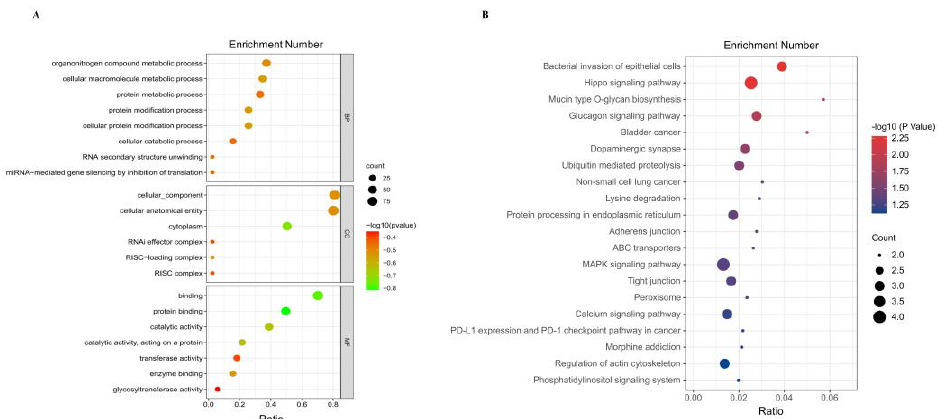
Figure 3. GO and KEGG enrichment analysis of DEcircRNA source genes. ( A ) GO analysis of DEcircRNA host genes in QE vs HE. The results are summarized in three main categories, biological processes (BP), cellular components (CC) and molecular functions (MF). ( B ) KEGG analysis of DEcircRNA host genes in QE vs HE.